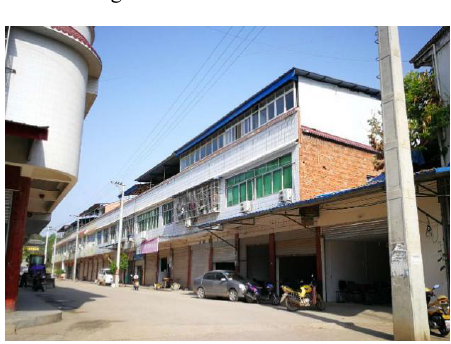
Figure 2 Location of test area.